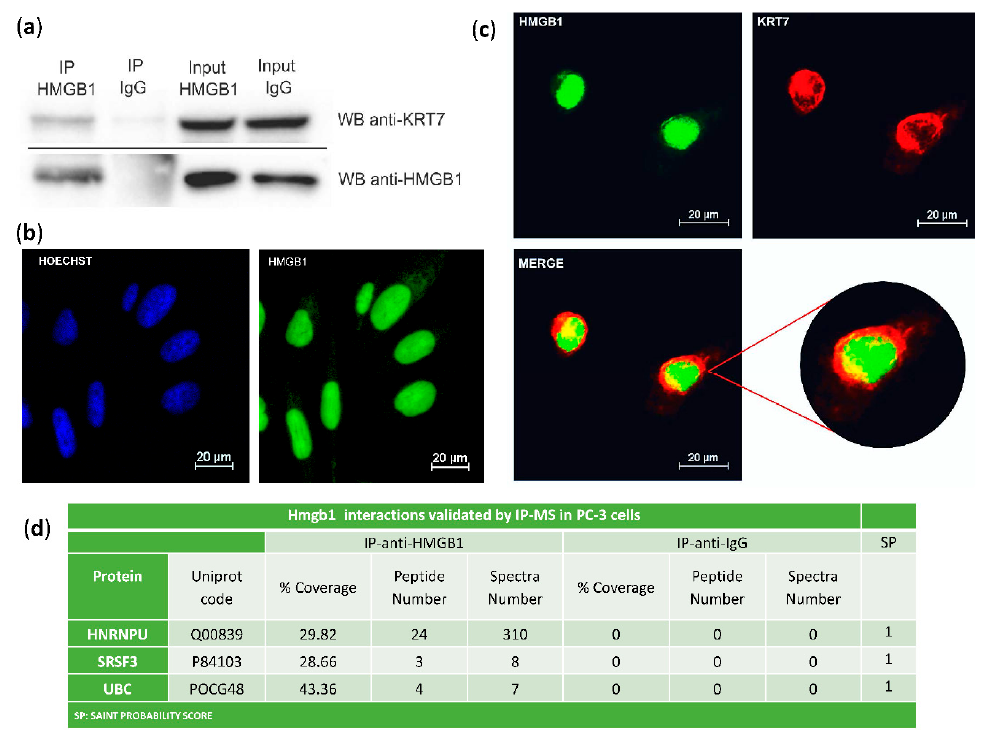
Figure 2. Validation of HMGB1-interactions: ( a ) Cytokeratin-7 co-immunoprecipitation with HMGB1. PC-3 lysates were immunoprecipitated with anti-HMGB1 antibody or normal mouse IgG and